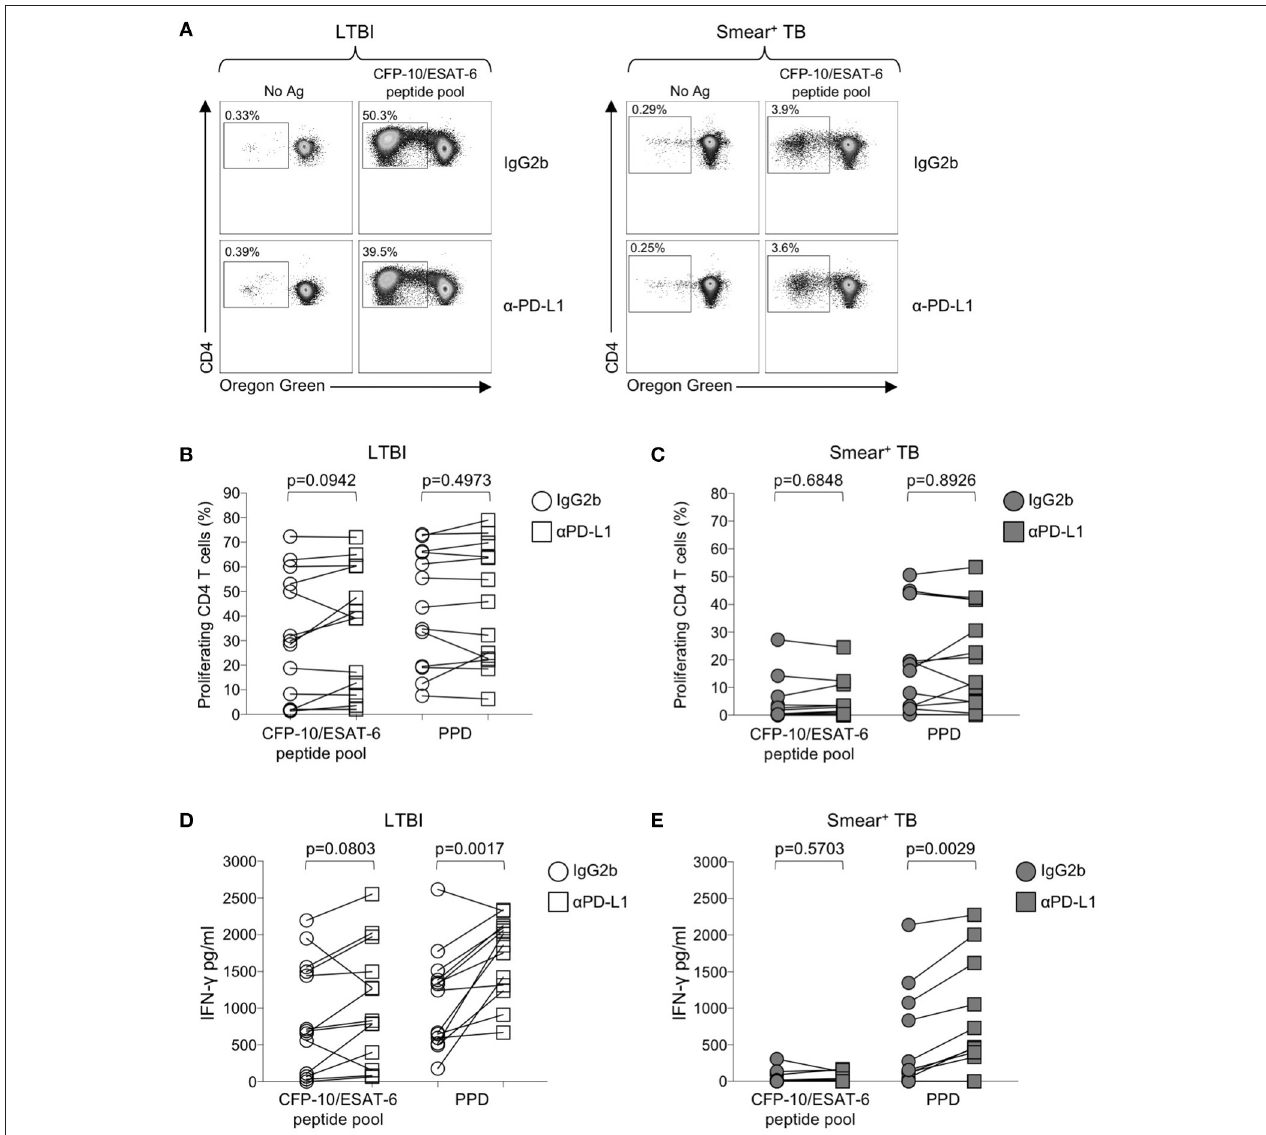
FIGURE 6 | Blockade of the PD-1/PD-L1 signaling pathway can augment Mtb-specific IFN- γ secretion, but not CD4T cell proliferative capacity. Proliferation assays were performed using freshly isolated PBMC labeled with Oregon Green (OG) and incubated for 6 days under the following conditions: media alone (negative control), CFP-10/ESAT-6 peptide pool, and SEB (positive control). Proliferation assays were performed in the presence of either anti-PD-L1 blocking Ab, or an IgG2b isotype-matched control Ab ( n = 13 LTBI; n = 13 smear + TB). (A) Flow cytometry data indicating the frequency of proliferating CD4T cells following stimulation with CFP-10/ESAT-6 peptide pool, in the presence of anti-PD-L1 Ab or IgG2b isotype control Ab. Dot plots are shown gated on viable CD3 + CD4 + lymphocytes from an individual with LTBI (left) and a patient with smear + TB (right). (B,C) Comparison of the frequency of proliferating (OG lo ) CD4T cells stimulated with CFP-10/ESAT-6 peptide pool, in the presence of anti-PD-L1 Ab or IgG2b isotype control Ab. (D,E) Levels of IFN- γ in cell culture supernatants of PBMC stimulated with CFP-10/ESAT-6 peptide pool for 6 days in the presence of anti-PD-L1 Ab or IgG2b isotype control Ab. Levels of IFN- γ were quantified by ELISA; data are shown after subtraction of background IFN- γ production in the negative control (media alone) conditions. Differences in proliferative capacity and IFN- γ secretion in the presence and absence of anti-PD-L1 Ab were determined using the Wilcoxon matched pairs signed rank test.